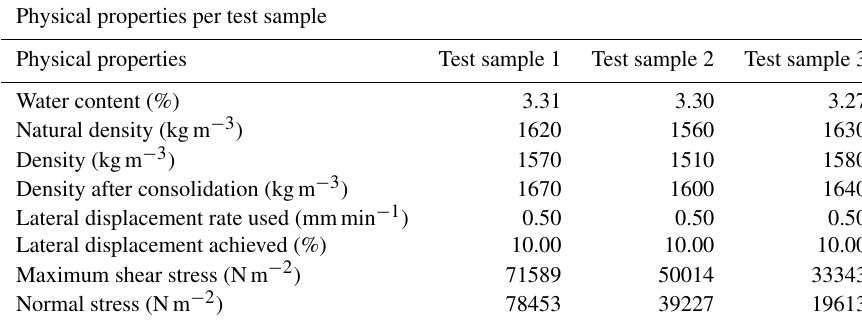
Table 1. Properties obtained by direct shear test. Geotechnical results incorporated into the r.avaflow model as